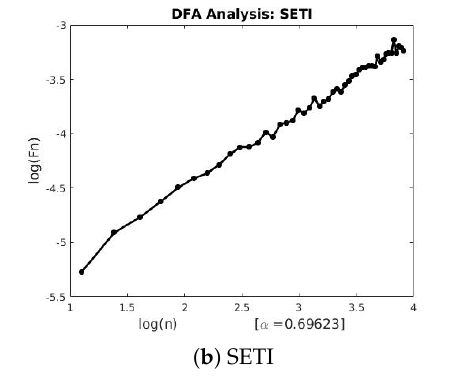
Figure A3. DFA for PSI and